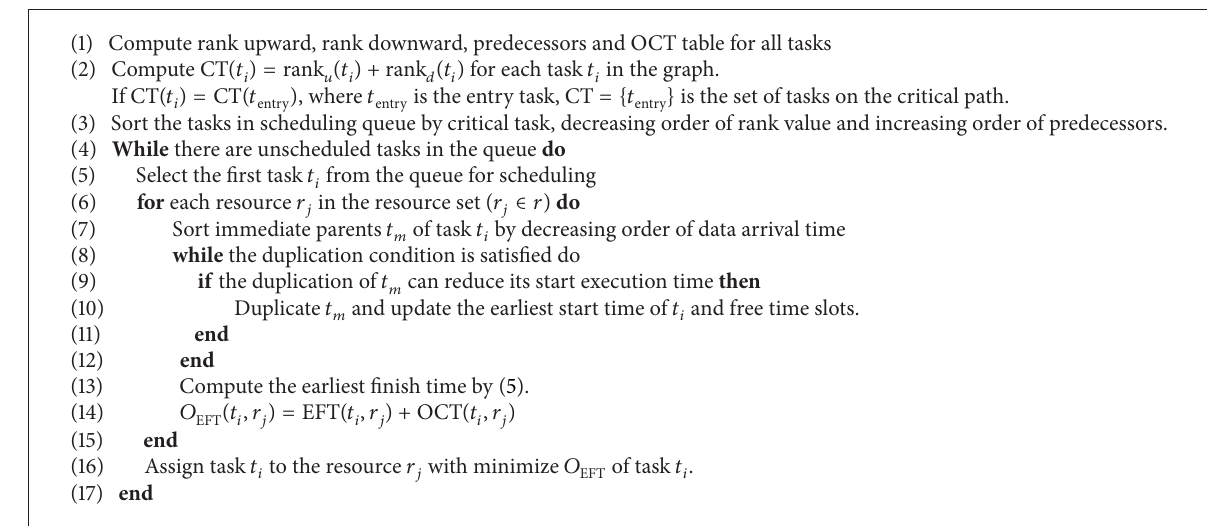
Algorithm 1: The HCPPEFT